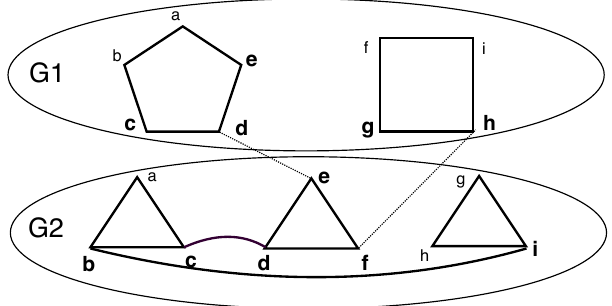
Figure 6. MCD: The vertices of a minimum connected dominating set are { c , d , e , g , h } from G 1 and { b , c , d , e , f , i } from G 2 . The cardinality of any MCD of G is 11. The vertices of MCD are shown in larger bold